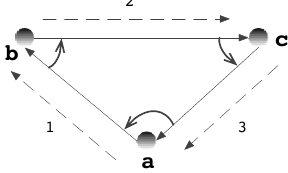
Figure 1. Right-hand rule forwarding.